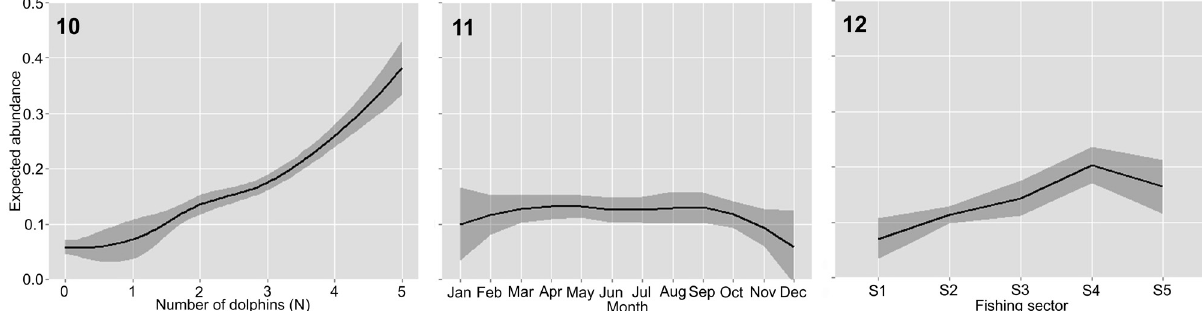
Figures 10–12. Expected abundance of Mugil liza for predictors of the gamma model. Number of dolphins (10), month (11) and fishing area (12); the black line indicates the moving average; dark gray areas represent the 95% confidence intervals of the predictions.